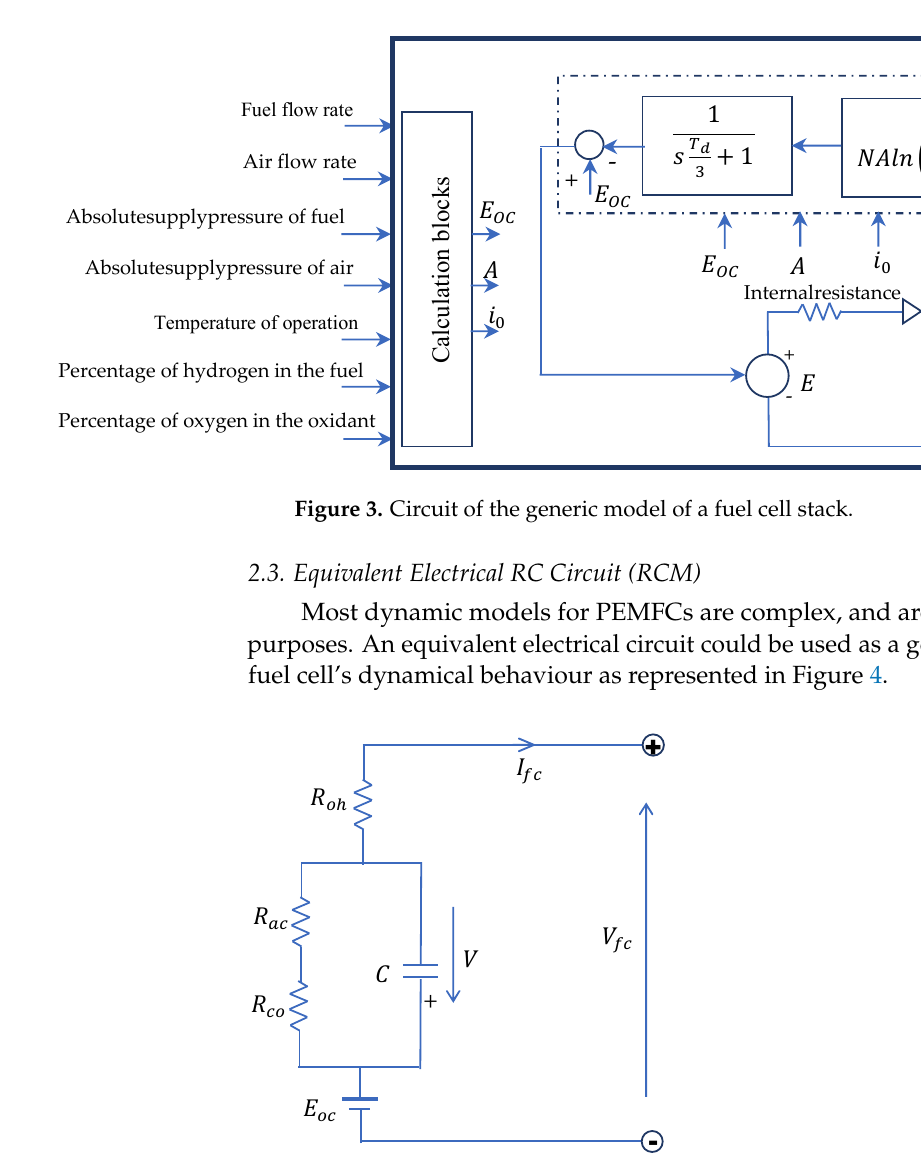
Figure 3. Circuit of the generic model of a fuel cell stack.